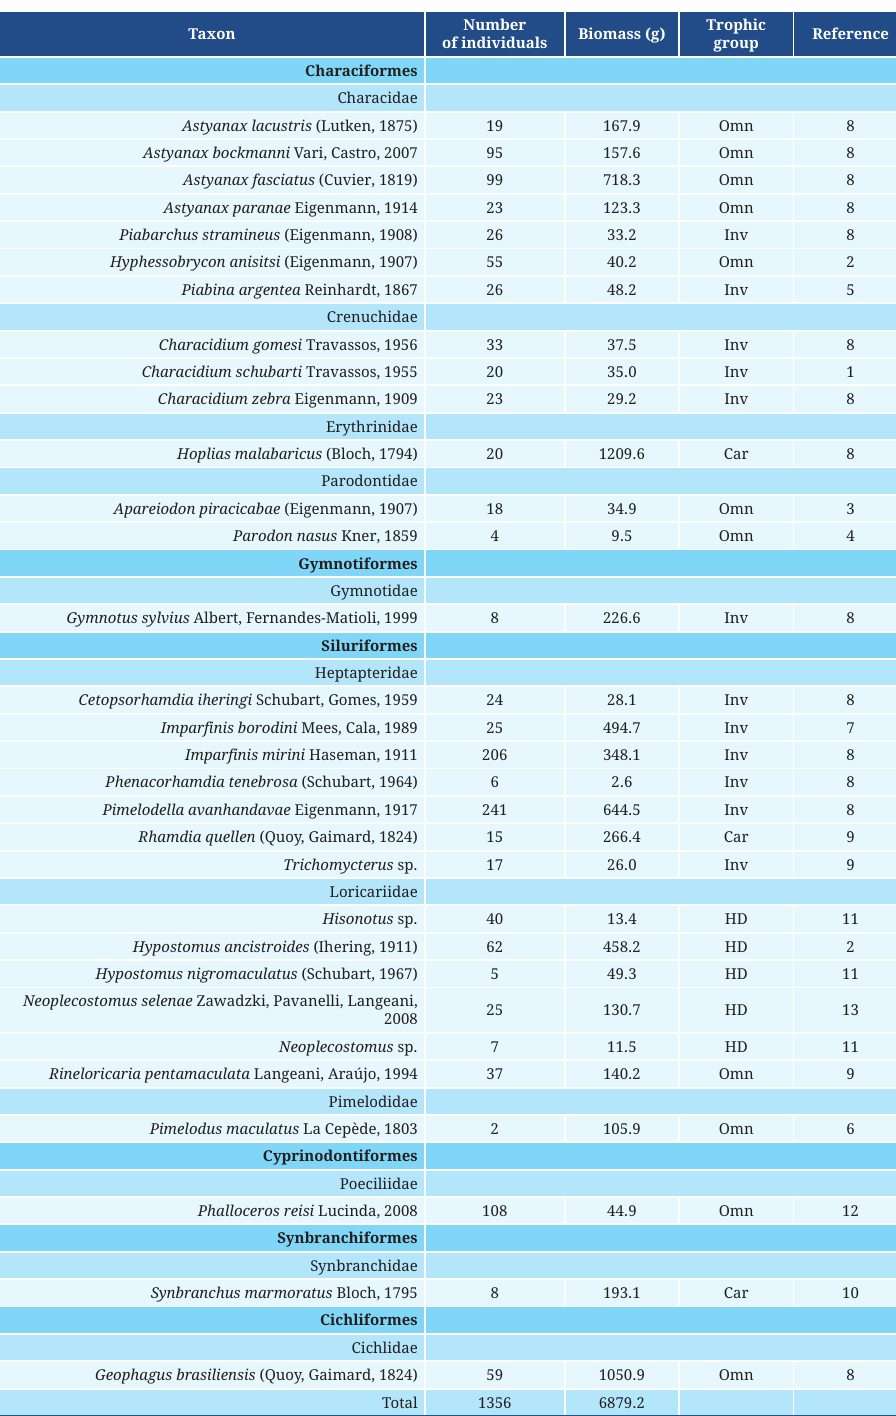
TABLE 3 | Data used to assess trophic group descriptors. Car = Carnivore; Inv = Invertivore; Omn = Omnivore; H-D = Herbivorous-Detritivores. References: 1 – Motta, Uieda (2004); 2 – Oliveira, Bennemann (2005); 3 - Gealh (2007); 4 – Gomiero, Braga (2008); 5 - Casatti et al . (2009B); 6 - Lobon- Cerviá, Bennemann (2000); 7 - Rondinelli et al . (2011); 8 - Casatti et al . (2012); 9 - Silva et al . (2012); 10 – Montenegro et al . (2012); 11 - Lujan et al. (2012); 12 - Smith et al. (2013); 13 – This